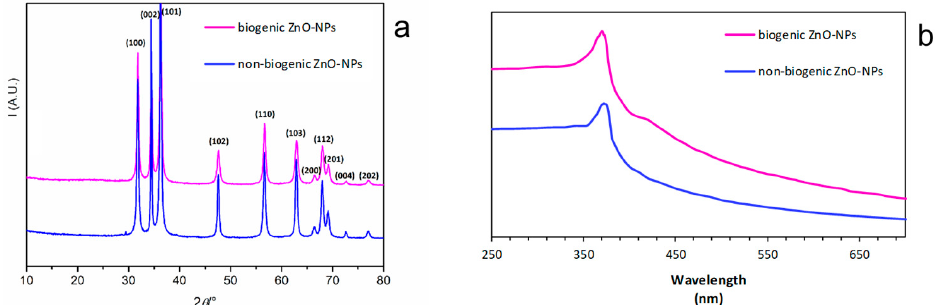
Figure 1. XRPD ( a ) and UV-vis ( b ) patterns of biogenic and non-biogenic ZnO-NPs.